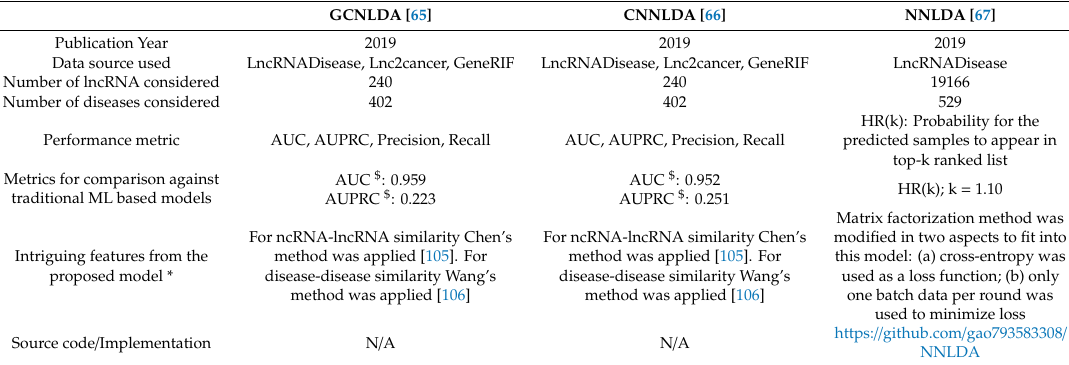
Table 5. Overview of articles for lncRNA–disease association prediction leveraging DL-based techniques. GCNLDA [65] CNNLDA [66] NNLDA [67] 2019 2019 Data source used LncRNADisease, Lnc2cancer, GeneRIF LncRNADisease, Lnc2cancer, GeneRIF LncRNADisease Number of lncRNA considered 240 240 402 402 529 top-k ranked list Metrics for comparison